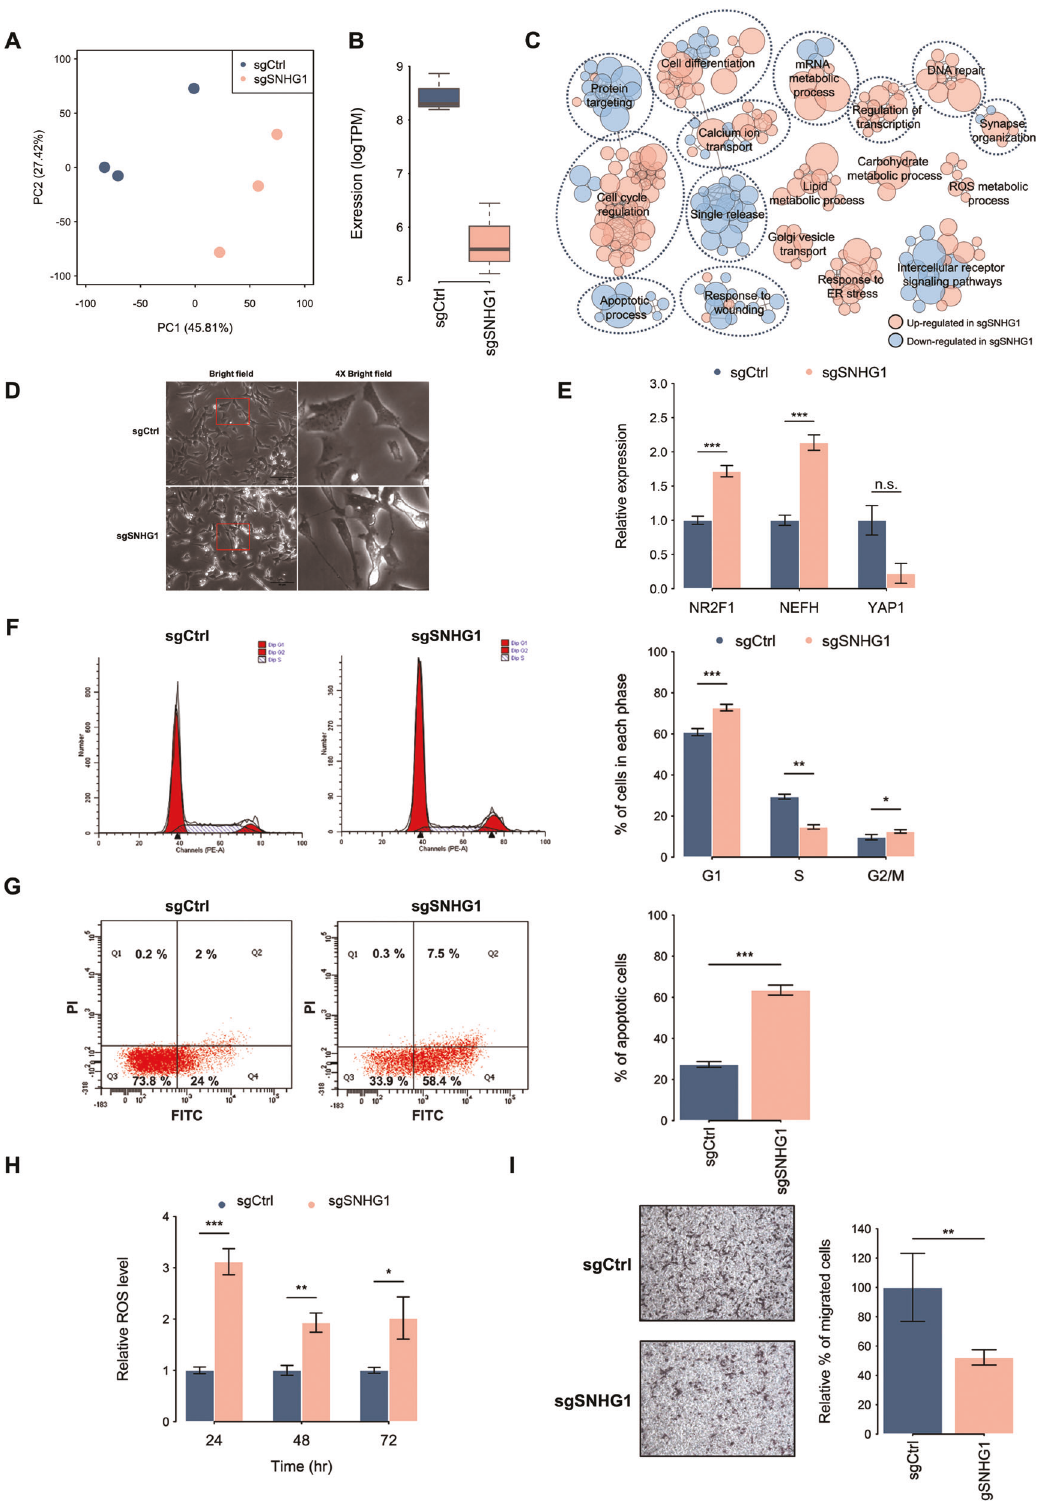
2C and Table S2). Functional assays were used to further validate the effect of the depletion of SNHG1 expression, and showed induced cell differentiation (Fig. 2D, E), G1-phase cell cycle arrest (Fig. 2F), apoptosis (Fig. 2G), and ROS accumulation (Fig. 2H), as well as suppression of cell migration in NB cells (Fig.